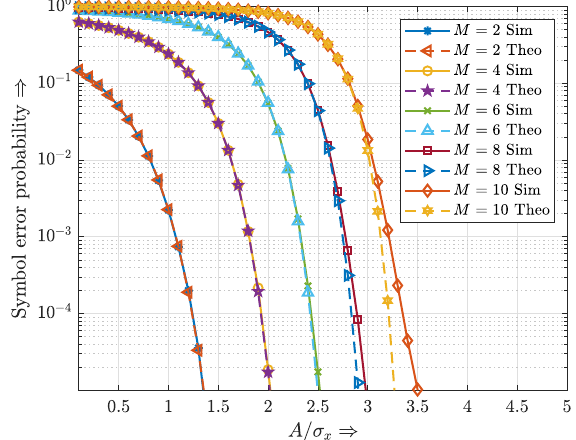
Figure 3. Theoretical versus simulated symbol error probability in a clipped OFDM transmission system, based on the Bussgang theorem. No low-pass filter on the receiving side is used here.